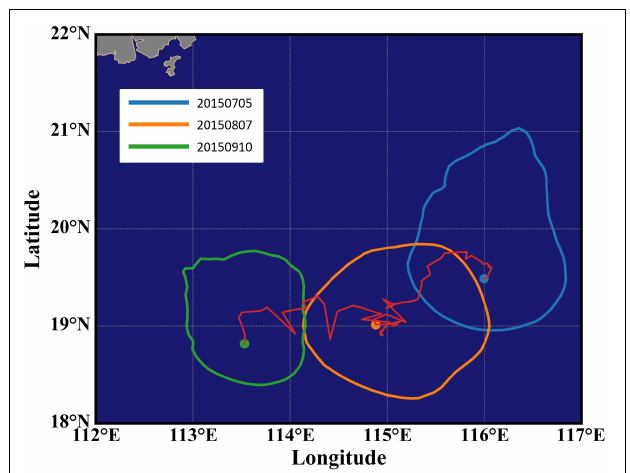
FIGURE 1 | The trajectory of the target eddy (red line) and the eddy boundary on birth (20150705, blue line), death (20150910, green line), and intermediate days (20150807, orange